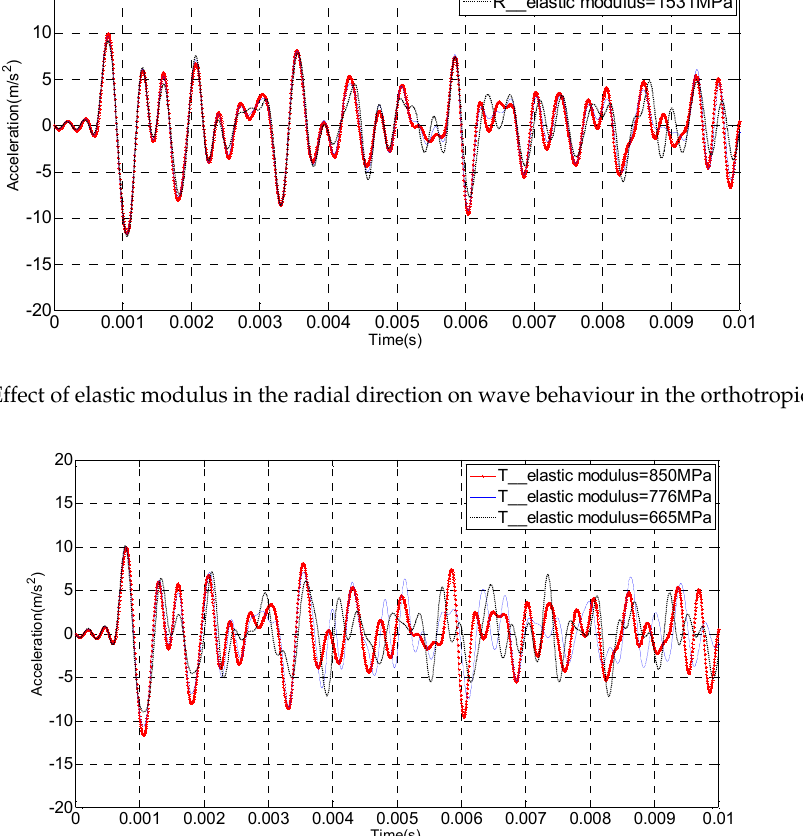
Figure 15. Effect of elastic modulus in the tangential direction on wave behaviour in the orthotropic model.